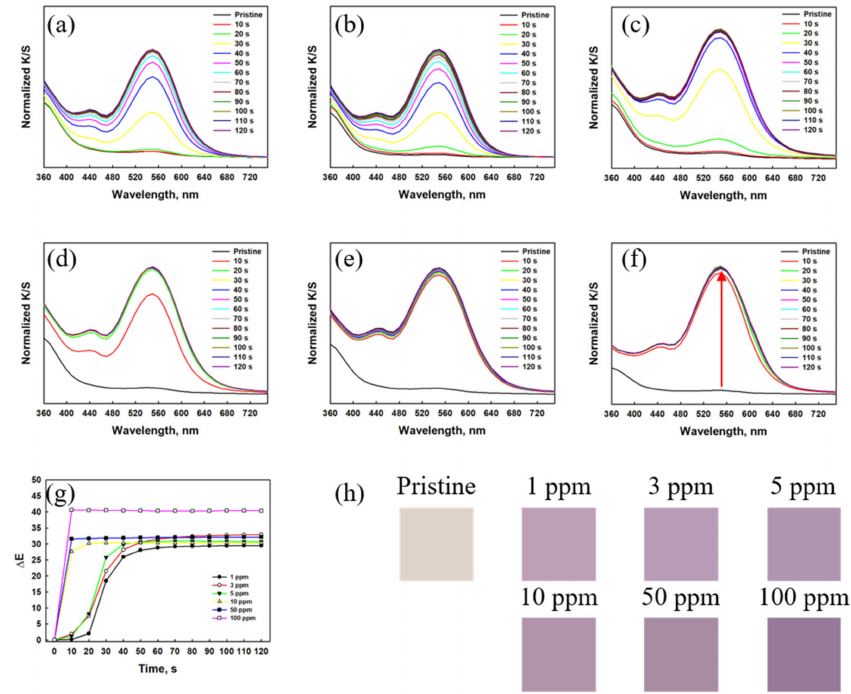
Figure 3. Color data for the textile sensor based on RhYK after exposure to various concentrations of gaseous HCl: ( a – f ) Time-dependent K / S values upon exposure to 1, 3, 5, 10, 50, and 100 ppm HCl; ( g ) Time-dependent color di ff erences; ( h ) Color